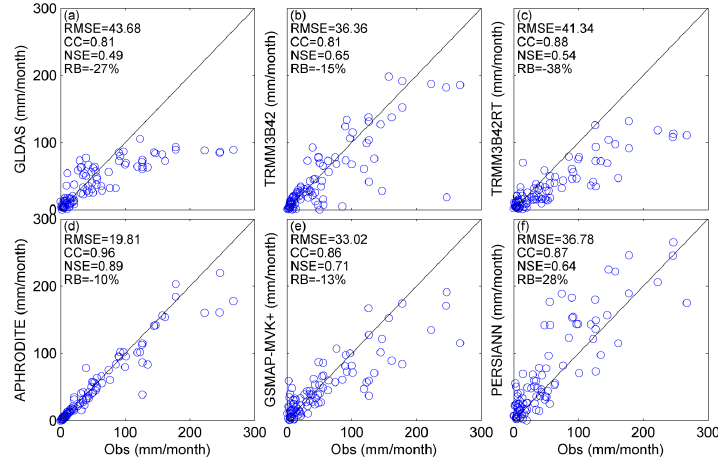
Figure 4. Scatter plots of basin-averaged precipitation products versus gauge observations at a monthly